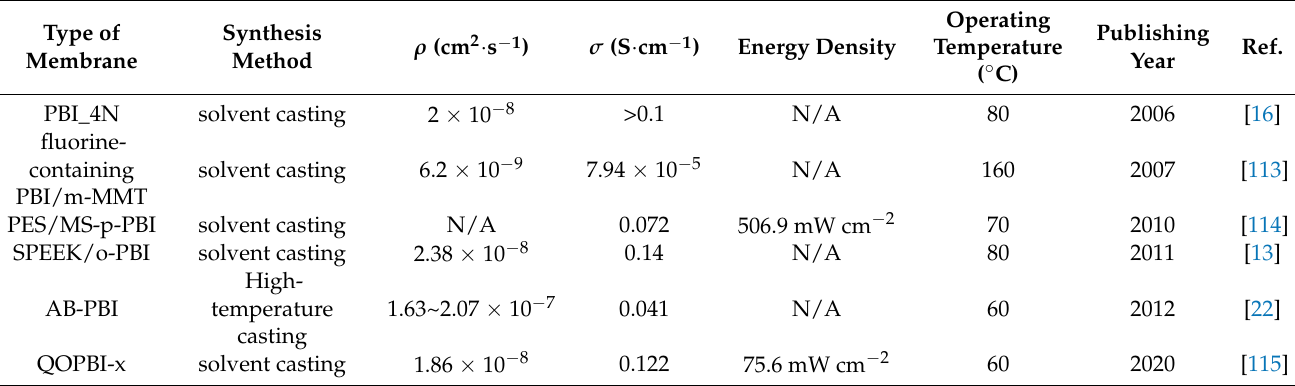
Table 4. The membrane properties of some representative studies on promoting the proton conductivity of PBI PEMs in DMFCs by synthesizing polymer structures (Acid components have been omitted in the column of “type of membrane” for phosphoric acid doped